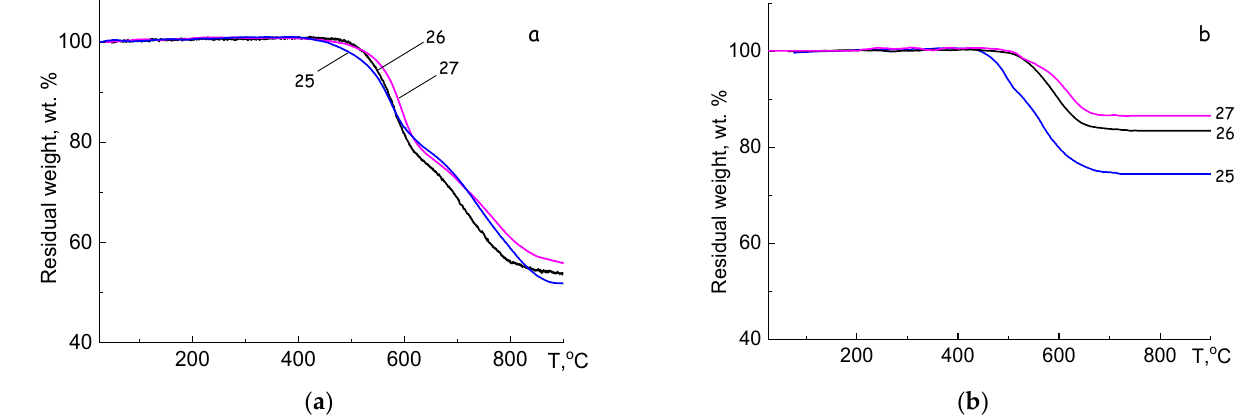
Figure 15. TGA curves of polymers 25 – 27 obtained at a heating rate of 10 degrees/min: ( a ) in air; ( b ) in argon. Table 7. Thermal data of polymers 25 – 27 .